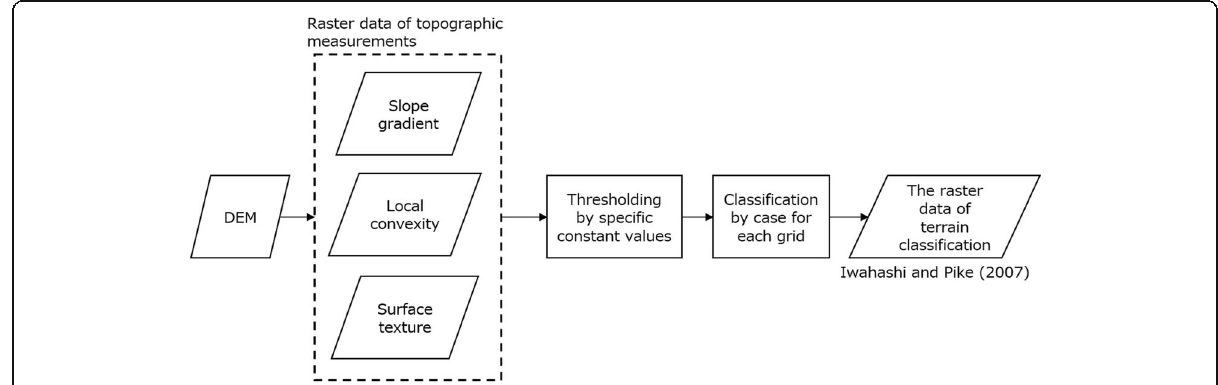
Fig. 1 Outline of the classification method of Iwahashi and Pike